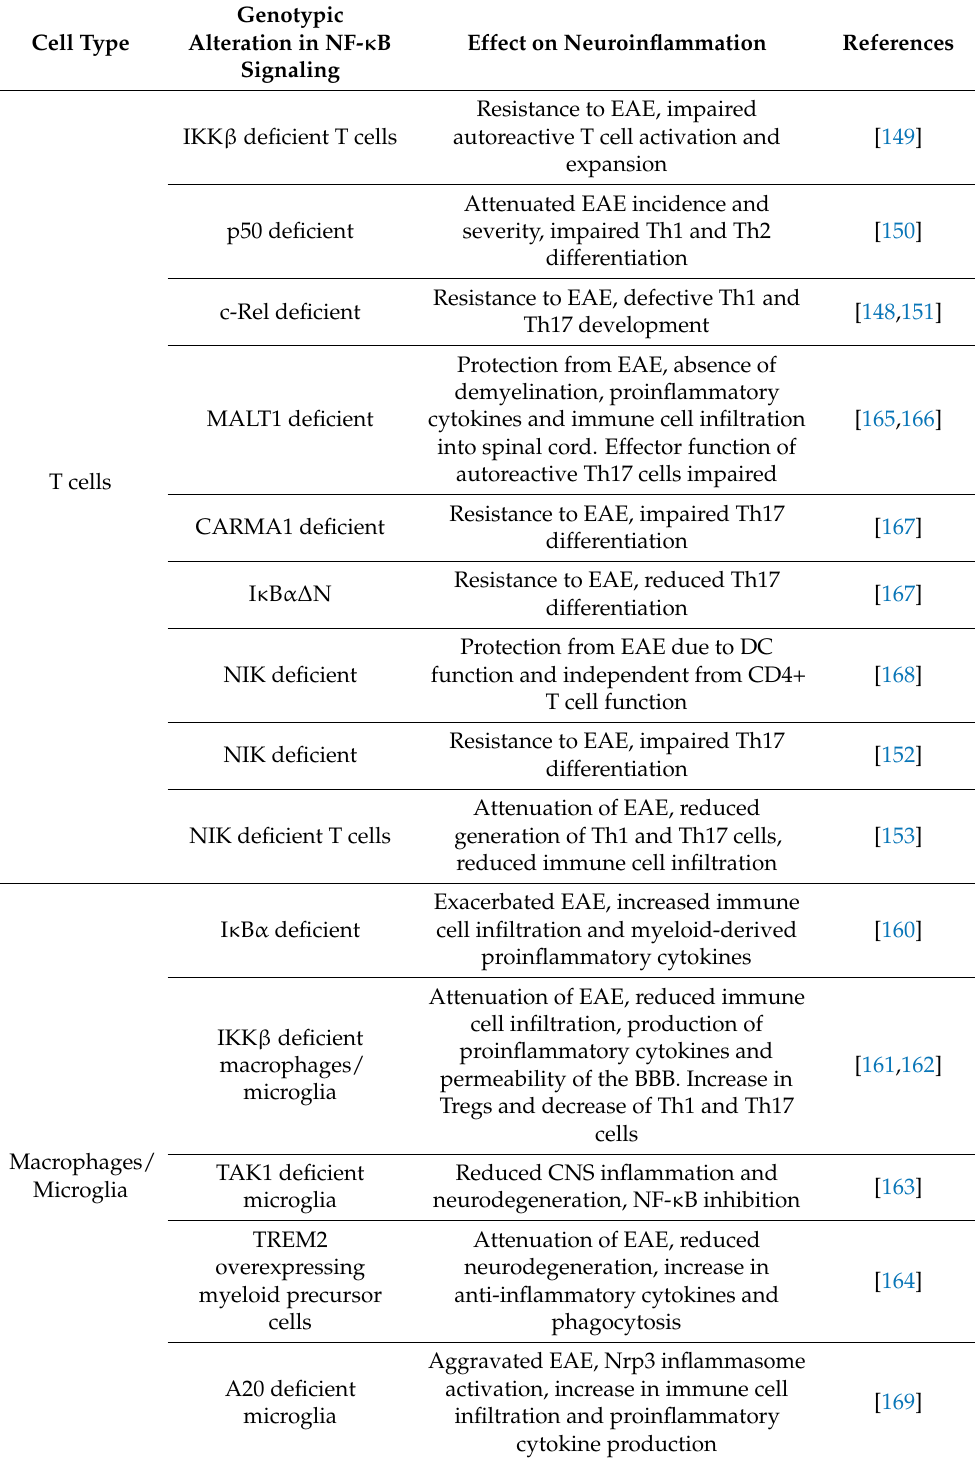
Table 4. Role of NF- κ B activity in different cell types in